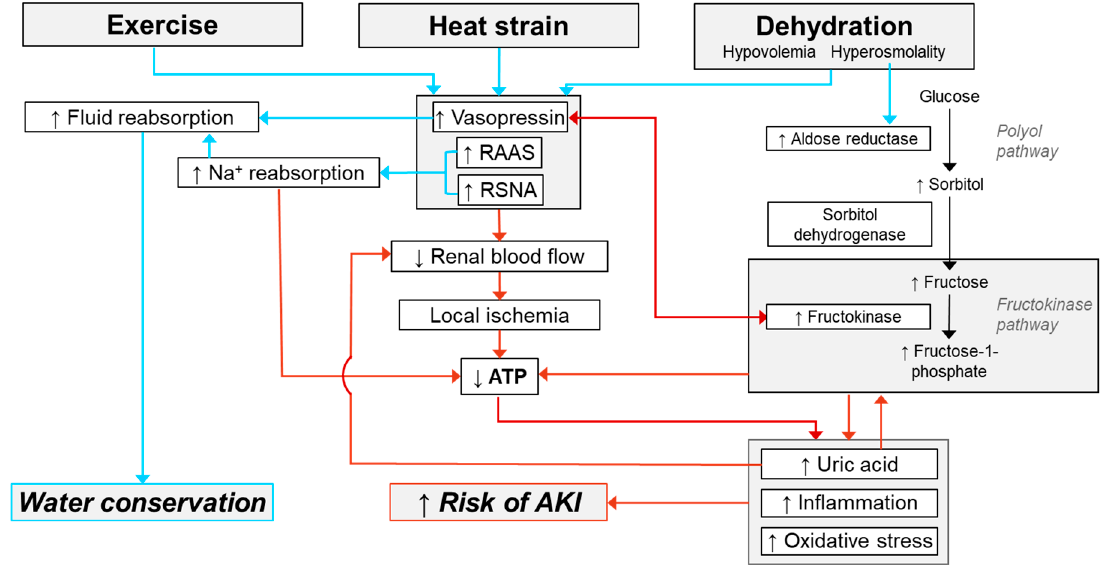
Figure 5. Potential mechanisms by which exercise in the heat and the subsequent development of heat strain (i.e., increases in core body temperature) and dehydration (a hypovolemic, hyperosmotic state) may increase the risk of acute kidney injury (AKI) while simultaneously promoting fluid conservation. Red arrows indicate potential pathophysiological pathways. Blue arrows indicate known beneficial physiological responses. Abbreviations—RAAS: Renin–angiotensin–aldosterone system, RSNA: Renal sympathetic nerve activity, ATP: adenosine triphosphate. Please refer to text for